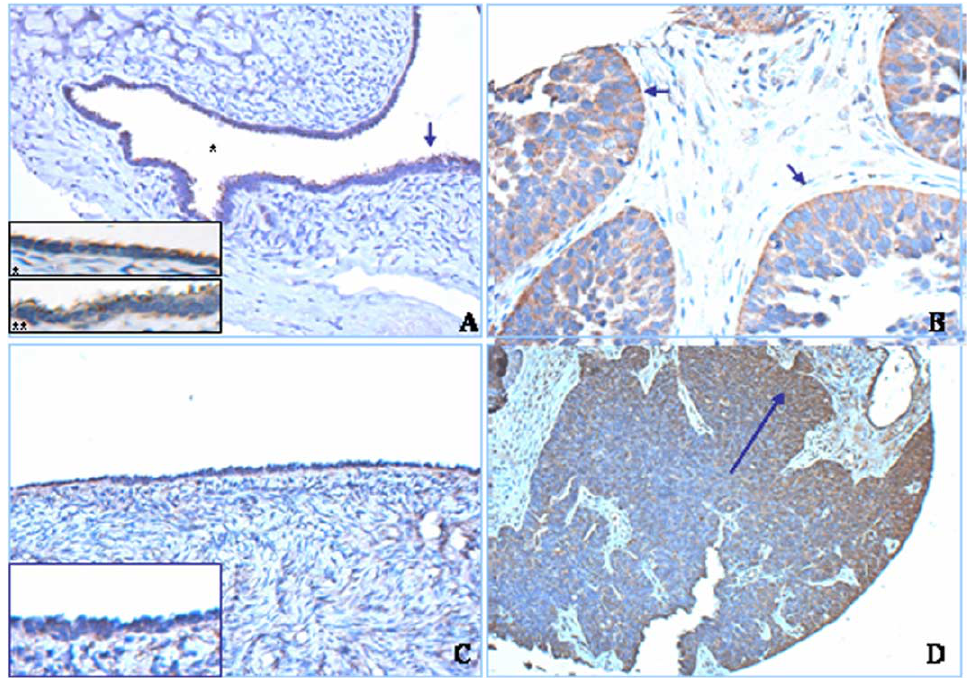
Fig. 5. Furin expression in tumors. Immunohistochemistry showing absent or low expression of furin in normal surface epithelium ((A) and (C)) and higher expression in tumors ((B) and (D)). The upper and lower panels show immunostaining using the monoclonal antifurin antibody MON-148 ((A)–(B)) and rabbit antifurin antiserum ((C)–(D)), respectively. Insets in (A): ∗ negative control (without first antibody), ∗∗ furin immunostaining. Arrow: Increased furin expression in the tumor-stroma boundary.